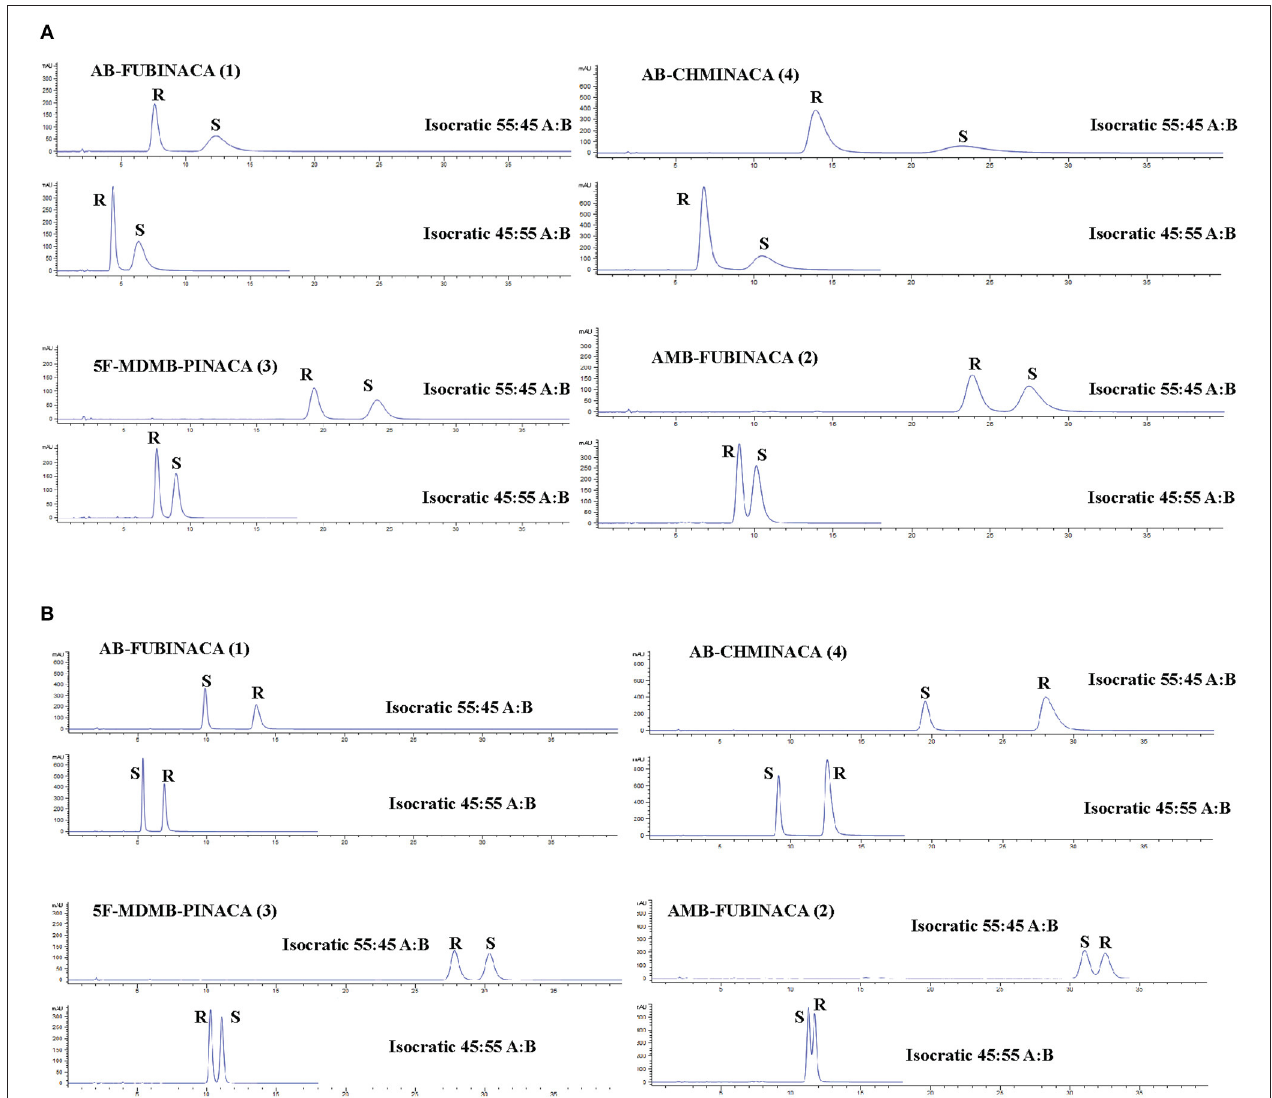
FIGURE 4 | HPLC-PDA chromatograms showing the resolution of indazole-3-carboxamide synthetic cannabinoid receptor agonists on (A) a Lux ® Amylose-1 column and (B) a Lux ® i-Cellulose-5 column. Mobile phase components: A-H 2 O, B-Acetonitrile. Compound numbering relates to that provided in Figure 1